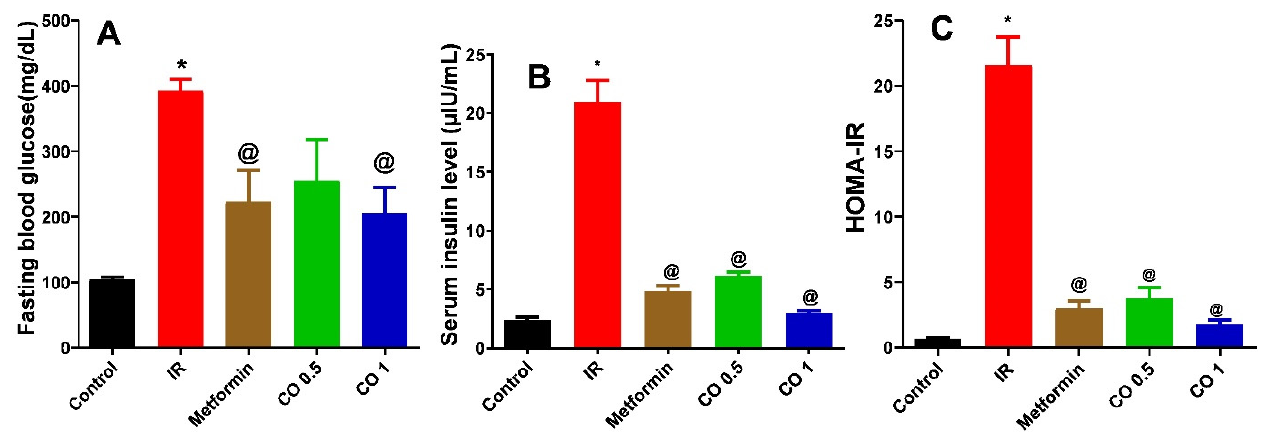
Figure 3. Effect of coriander oil (CO, 0.5 and 1 mL/kg, PO) and metformin (50 mg/kg/day, PO) on fasting blood glucose ( A ), serum insulin ( B ) and HOMA-IR ( C ) in dexamethasone induced insulin resistant rats (IR). Results were analyzed by one-way ANOVA followed by the Post-hoc Tukey test. Results are shown in mean ± SEM ( n = 6). * , @ p < 0.05 compared to normal, and IR groups, respec- tively.